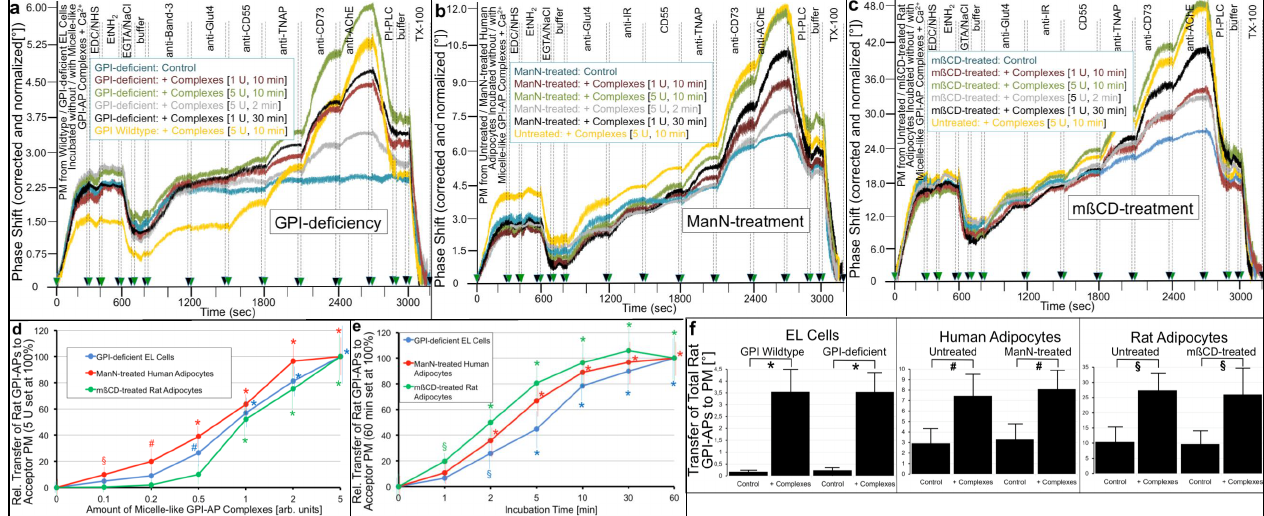
Figure 4. Transfer of full-length GPI-APs from micelle-like GPI-AP complexes to acceptor cells with reduced expression of GPI-APs. ( a ) Wildtype and GPI-deficient EL cells, ( b ) untreated and ManN-treated human adipocytes of lipid-loading stage II and ( c ) untreated and mßCD-treated rat adipocytes were incubated with buffer (Control) or the indicated amounts of micelle-like rat adipocyte GPI-AP complexes (prepared as described in Materials and Methods) for the indicated periods. The expression of rat adipocyte transmembrane proteins and GPI-APs at PM prepared from the cells was analyzed by SAW sensing as described in the legend to Figure 1. ( a – c ) PM from representative cell clones/preparations analyzed by different chips are shown, repeated two times with similar results. The measured phase shift is given upon correction and normalization as described for Figure 1. ( d , e ) GPI-deficient EL cells, ManN-treated human adipocytes and mßCD-treated rat adipocytes were incubated with increasing amounts ( d ) or two arb. units ( e ) of micelle-like GPI-AP complexes for 30 min ( d ) or increasing periods of time ( e ). ( d , e ) The mean values ± SD of the phase shift ∆ from three to four independent complex/cell preparations for both wildtype/control and GPI- deficiency/treatment induced by all antibodies against rat GPI-APs (summation signal between 1500 and 2700 s each) were used for calculation of relative transfer of rat GPI-APs to acceptor cells with maximal incubations (5 arb. units, 60 min) set at 100% each and significant differences vs. incubation with buffer for 60 min ( d ) or complexes (5 arb. units) for 0 min ( e ) indicated. ( f ) The mean values ± SD of the phase shift ∆ were used for calculation of transfer of total GPI-APs to acceptor PM for each cell type and incubation (5 arb. units of complexes, 10 min; yellow curves in a – c ) with significant differences vs. control (buffer, 10 min; blue curves in a – c ) indicated for each cell type (* p ≤ 0.01, # p ≤ 0.02, § p ≤